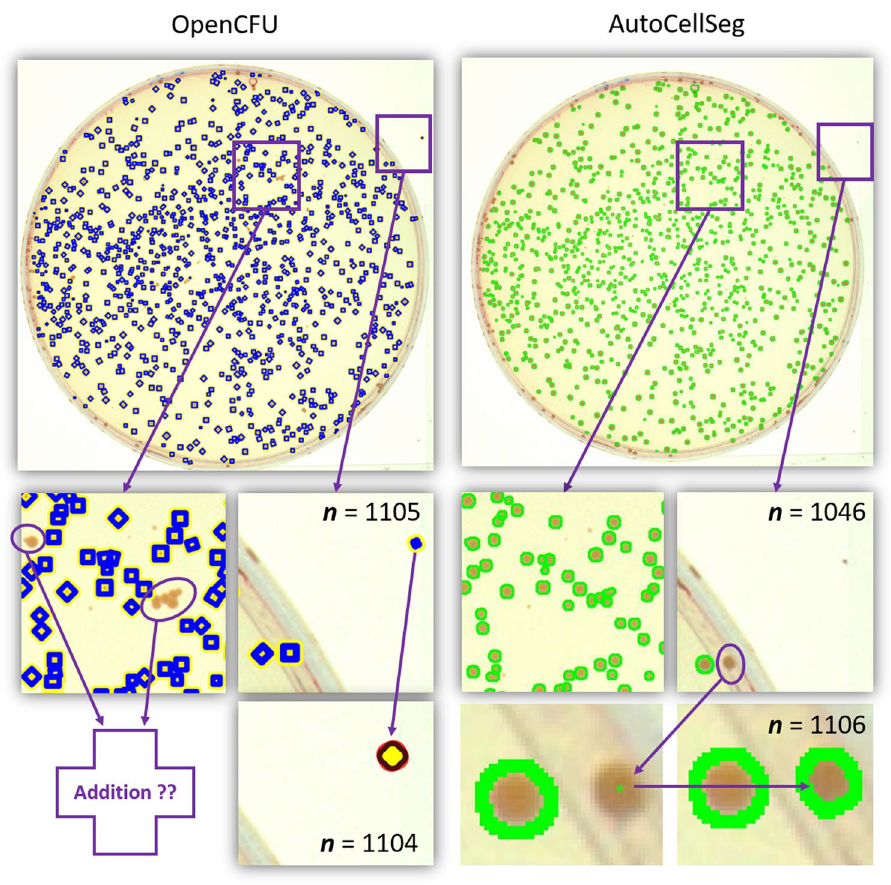
Figure 5. AutoCellSeg and OpenCFU segmentation results for the images with lighter background and darker colonies. The blue boxes (top-left image) show detection result from OpenCFU and green delineation (top-right image) is for AutoCellSeg segmentation. Zoomed-in sections of the selected image areas of images in first row without post-editing (second row). Result after correction step (last row). OpenCFU has missed a conglomeration of colonies (first image, second row). OpenCFU has detected some noise outside of the dish (second image, second row). AutoCellSeg segmentation of the same section as in first image of the second row (third image, second row). In AutoCellSeg, some colonies on the border of dish remain undetected (last image, second row). Erroneous segment detected outside could be deleted in OpenCFU (second image, last row). Undetected segments could be clicked upon interactively in AutoCellSeg (third image, last row). Based on the seed point defined by user, the undetected colony is segmented using fast marching method (last image, last